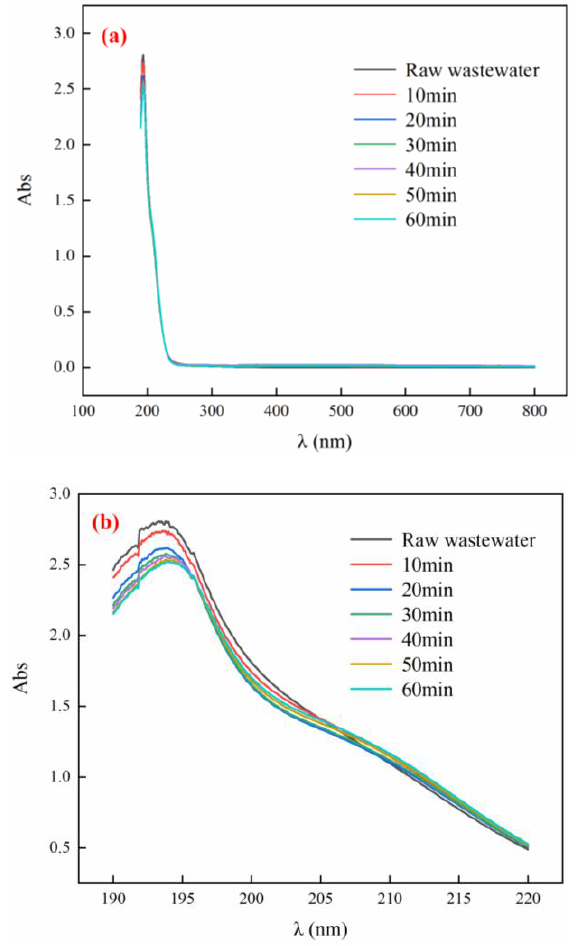
Figure 8. UV-Vis analysis results: ( a ) 190~1100 nm, ( b ) 190~220 nm.